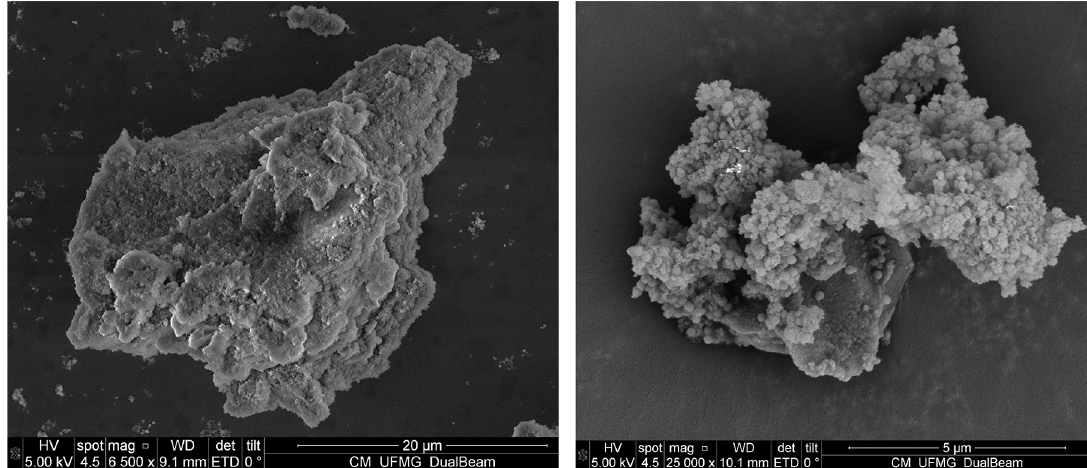
Figure 2. SEM images of synthetic aluminosilicate heat treated of 900 °C by secondary electrons: (a) structure and (b) structure with agglomerated silica.